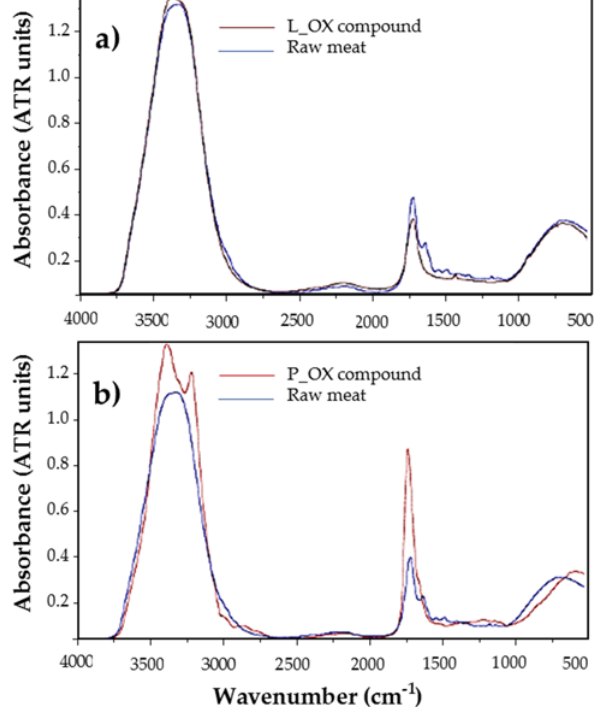
Figure 6. Comparison of marker compounds spectra vs. its raw meat samples: ( a ) L_OX (lipid oxidation) compound (brown) vs. raw meat animal (blue) ( b ) P_OX (protein oxidation) compound (red) vs. raw meat animal